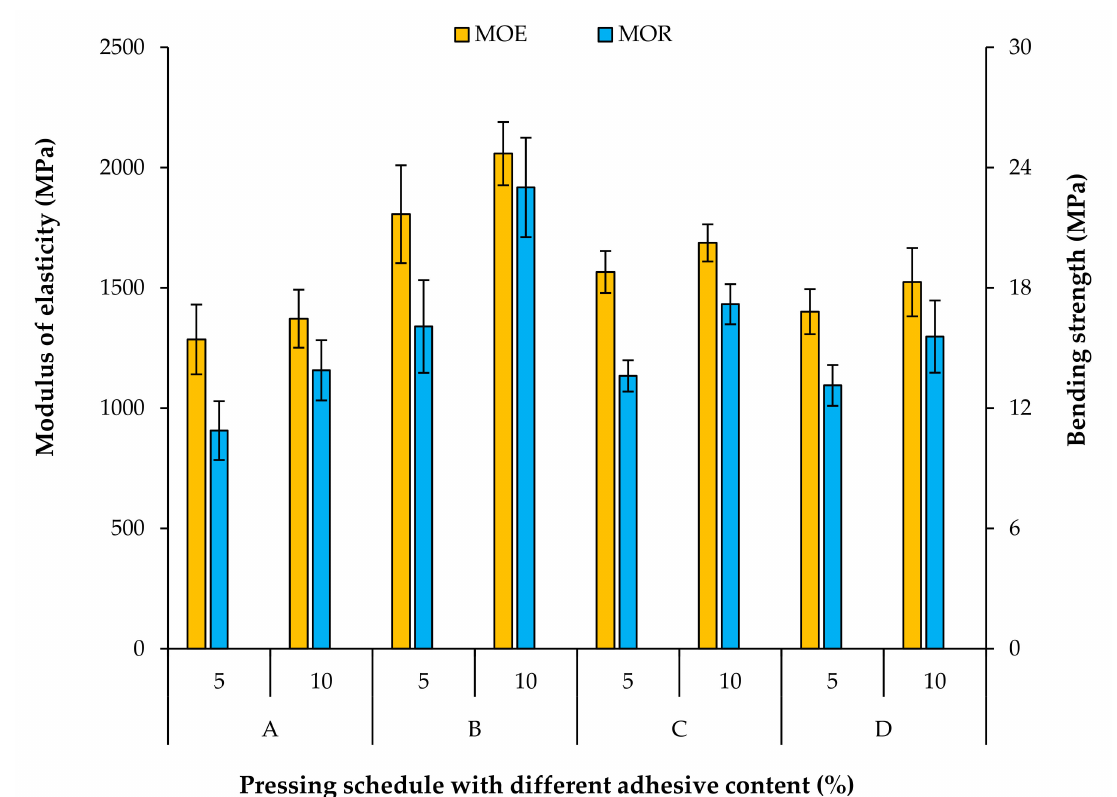
Figure 5. Bending properties of fiberboards produced with different pressing schedules and adhesive